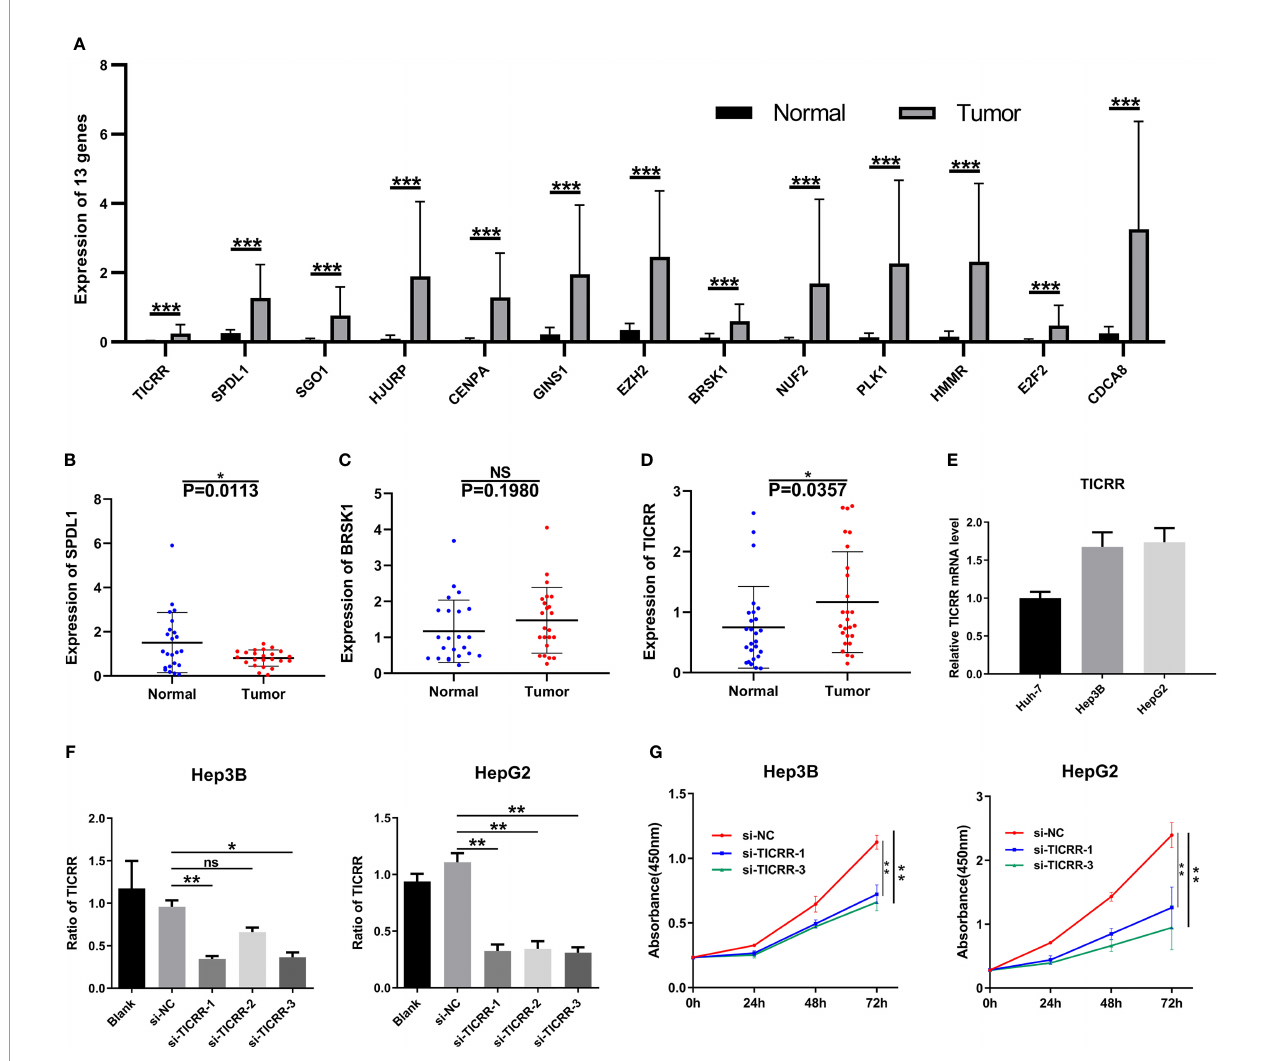
FIGURE 10 | Expression veri fi cation and functional experiments. (A) mRNA levels of the 13 genes in the HCC samples (n = 50) compared to normal peritumoral tissues (n = 50) in TCGA cohort. Expression of (B) SPDL1, (C) BRSK1, and (D) TICRR in HCC tissues (n = 23) compared to normal peritumoral tissues (n = 23), as measured by RT-qPCR. (E) Expression of TICRR in HUH-7, Hep3B, and HepG2 cells, as measured by RT-qPCR. (F) Knockdown ef fi ciency of TICRR in Hep3B and HepG2 using three independent siRNAs. (G) CCK-8 analysis showed that depletion of TICRR in Hep3B and HepG2 cells by 2 separate siRNAs led to decreased cell proliferation. *P < 0.05, **P < 0.01, and ***P < 0.001. NS, nonsigni fi